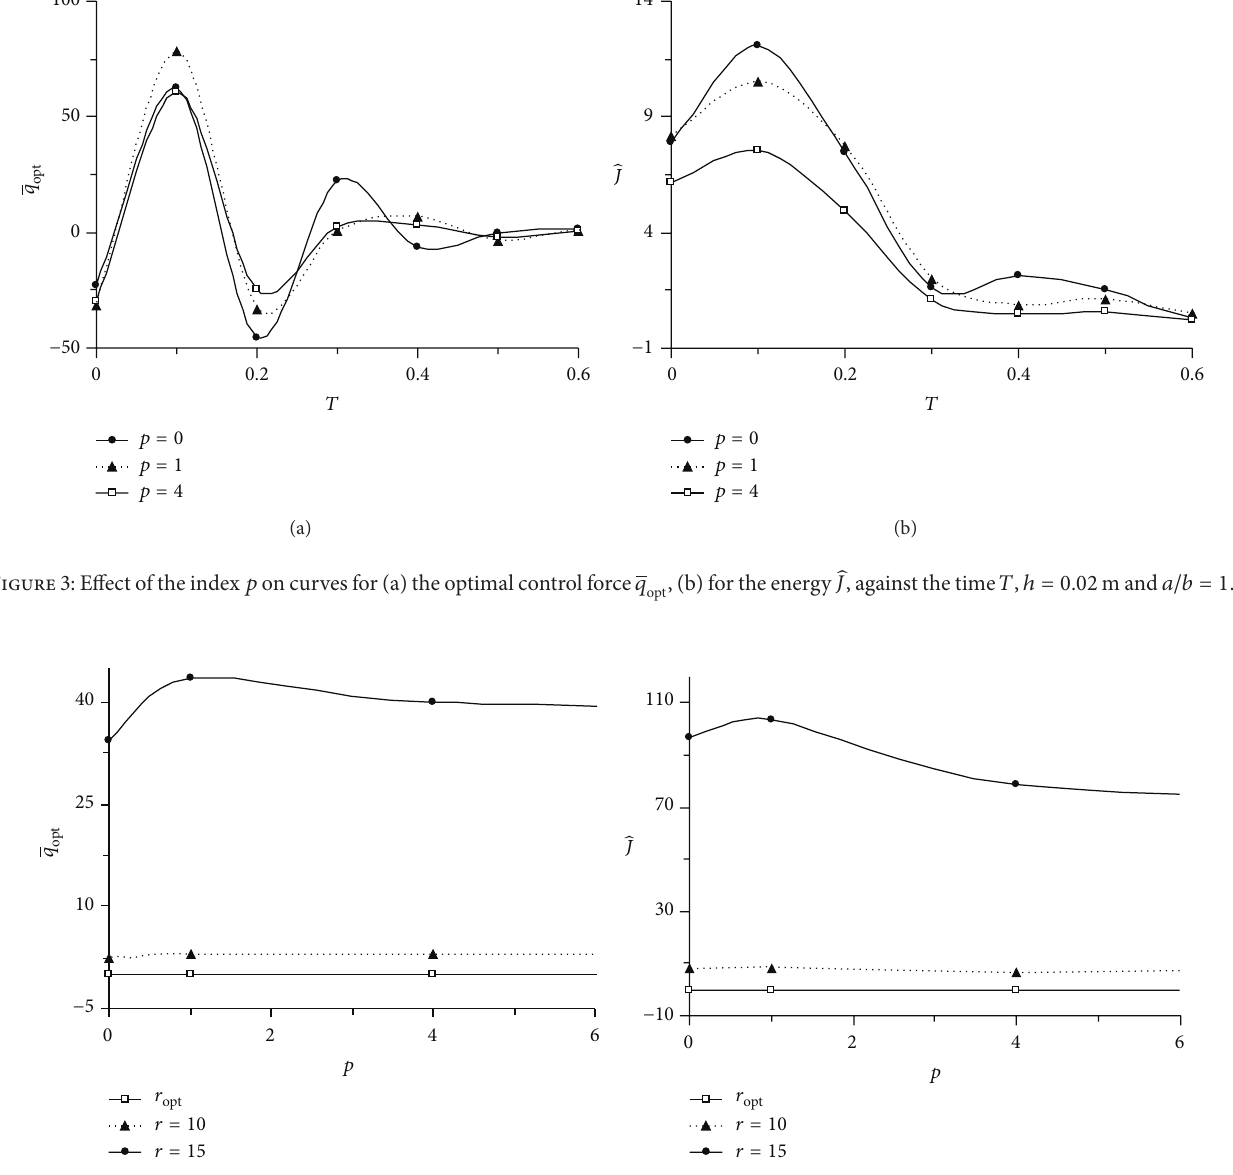
Figure 4: Effect of the thickness ratio 𝑟 and the index 𝑝 on curves of the control force 𝑞